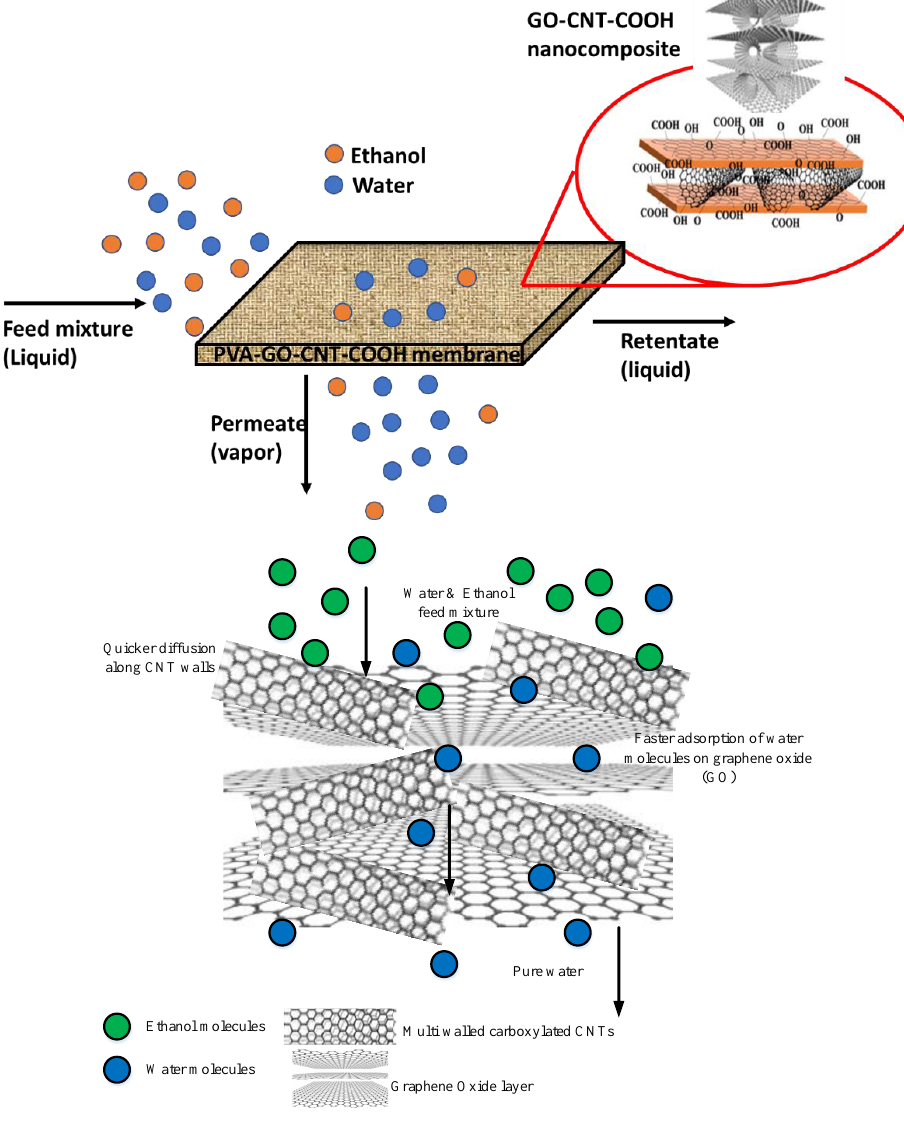
Figure 14. Schematic of proposed